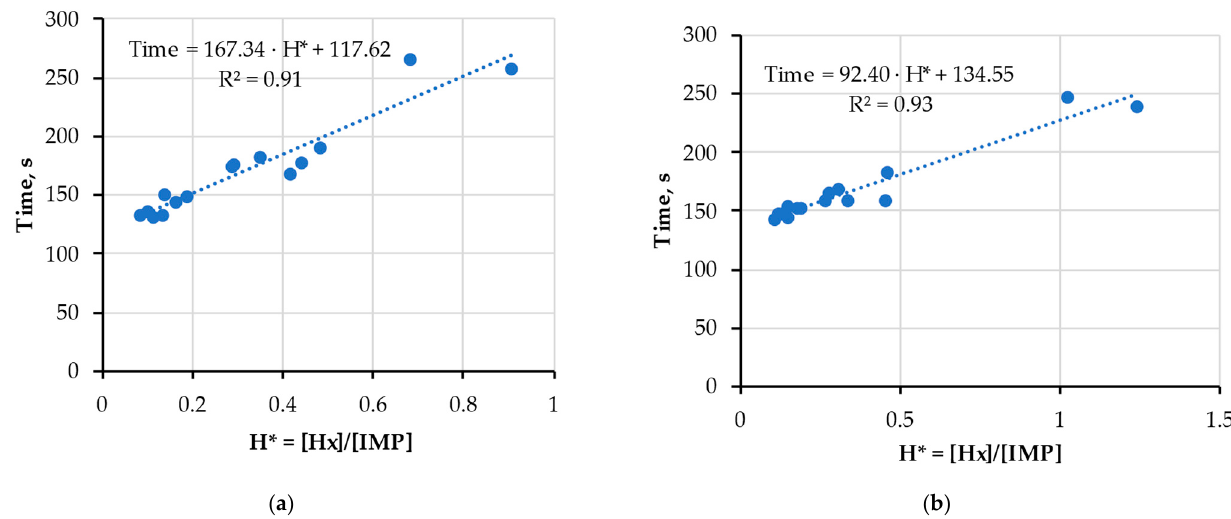
Figure 5. Correlation between the index H* and the index Time for raw ( a ) and cooked ( b ) minced pork stored or previously stored